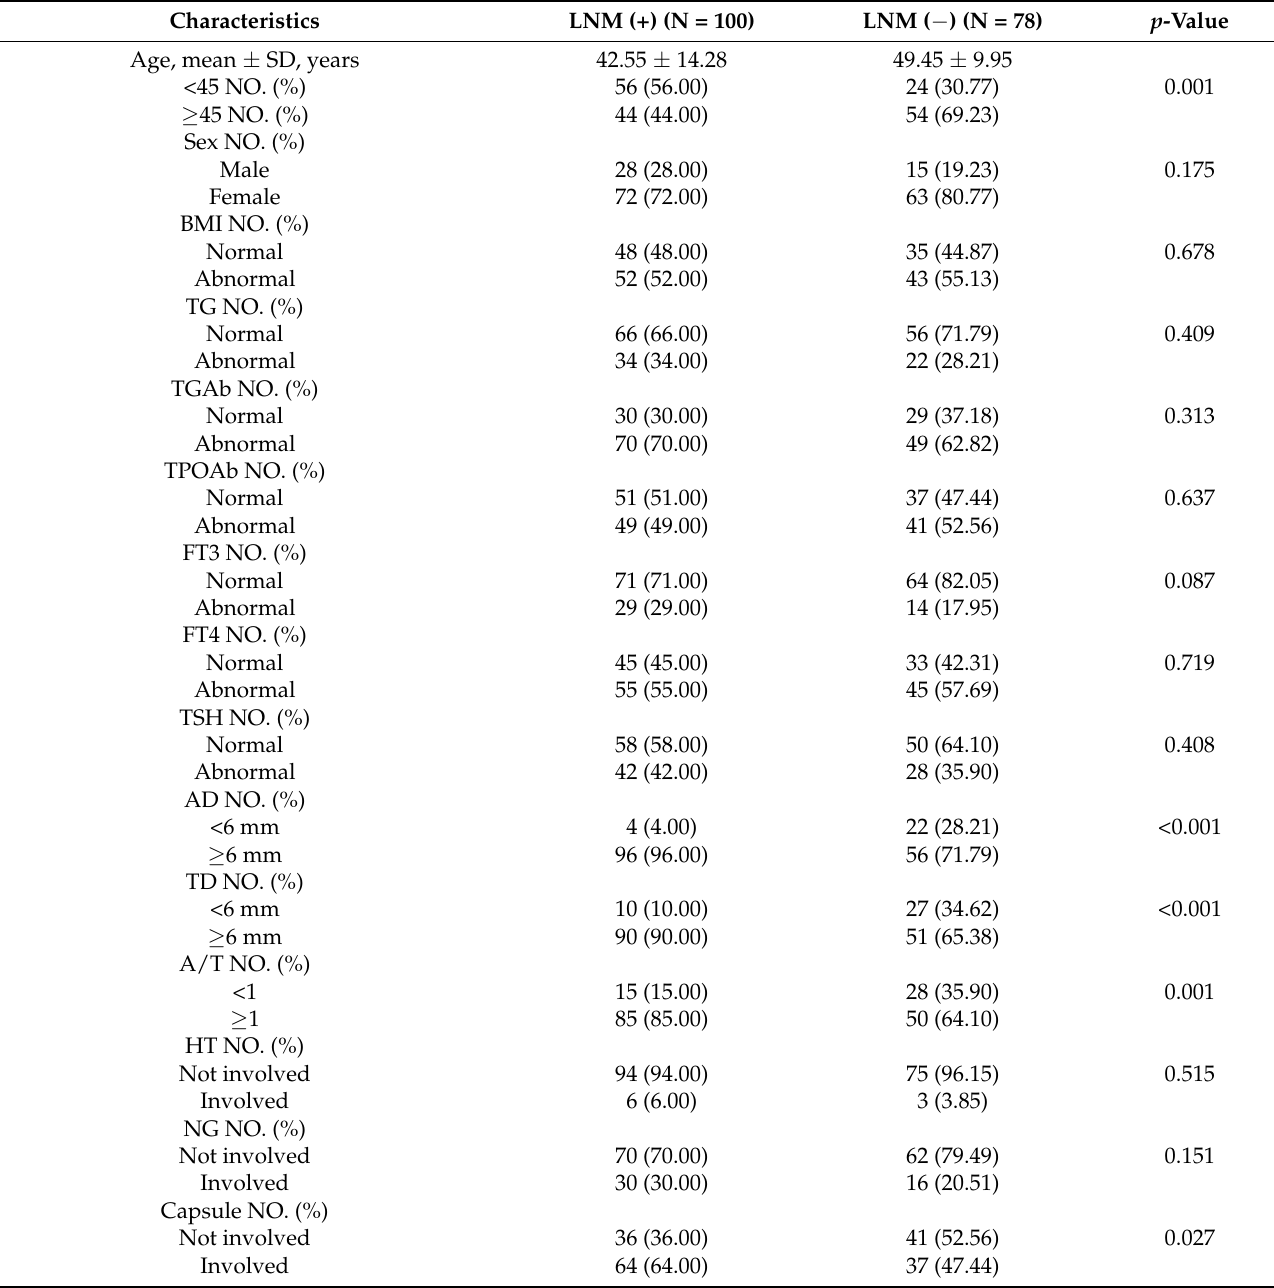
Table 1. Associations between LNM and clinical